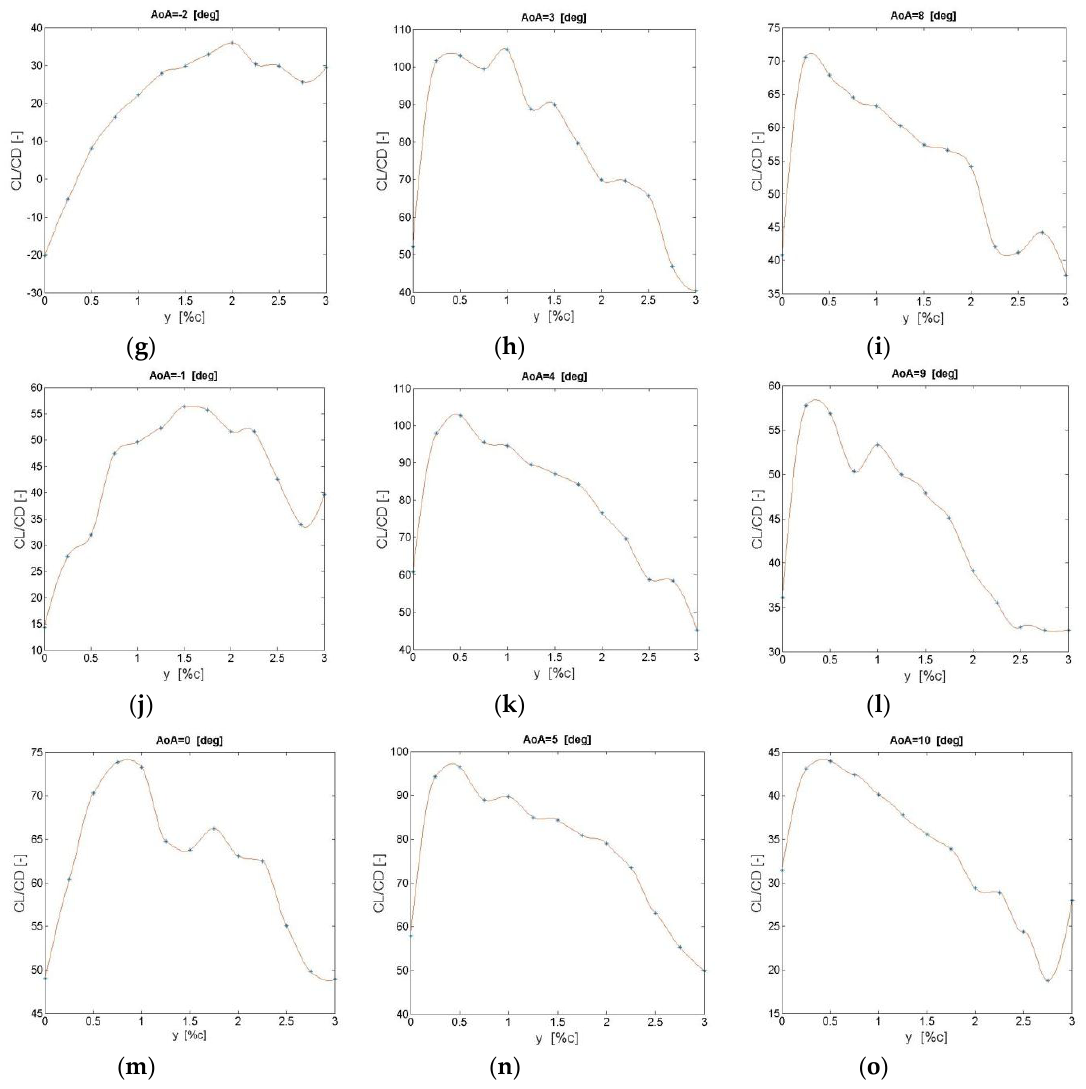
Figure A1. Lift-to-drag ratio of the S810 airfoil with GFs for each AoA. CFD results are denoted by * and the red line represents the POD approximation. Each sub-plot corresponds to an angle of attack AoA of the airfoil.